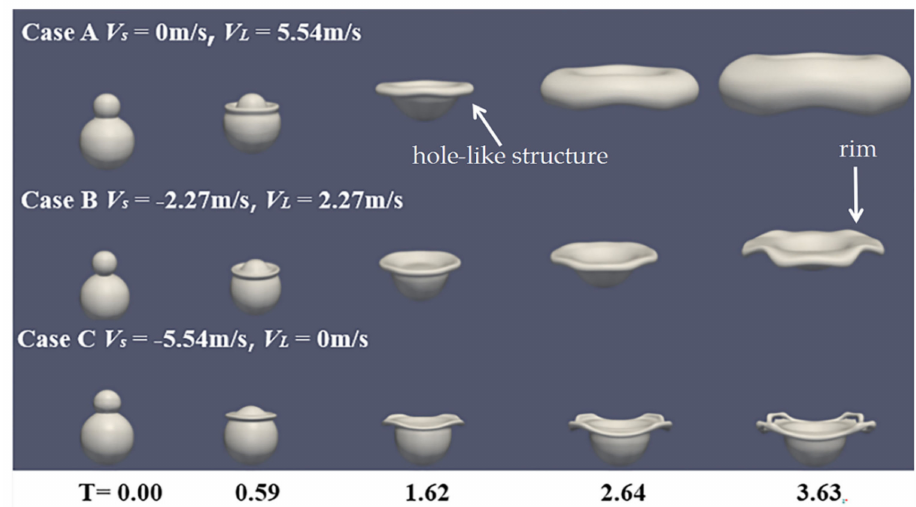
Figure 7. Shape evolution of binary droplets’ collision with the di ff erent initial velocity at We = 210, ∆ = 0.5.